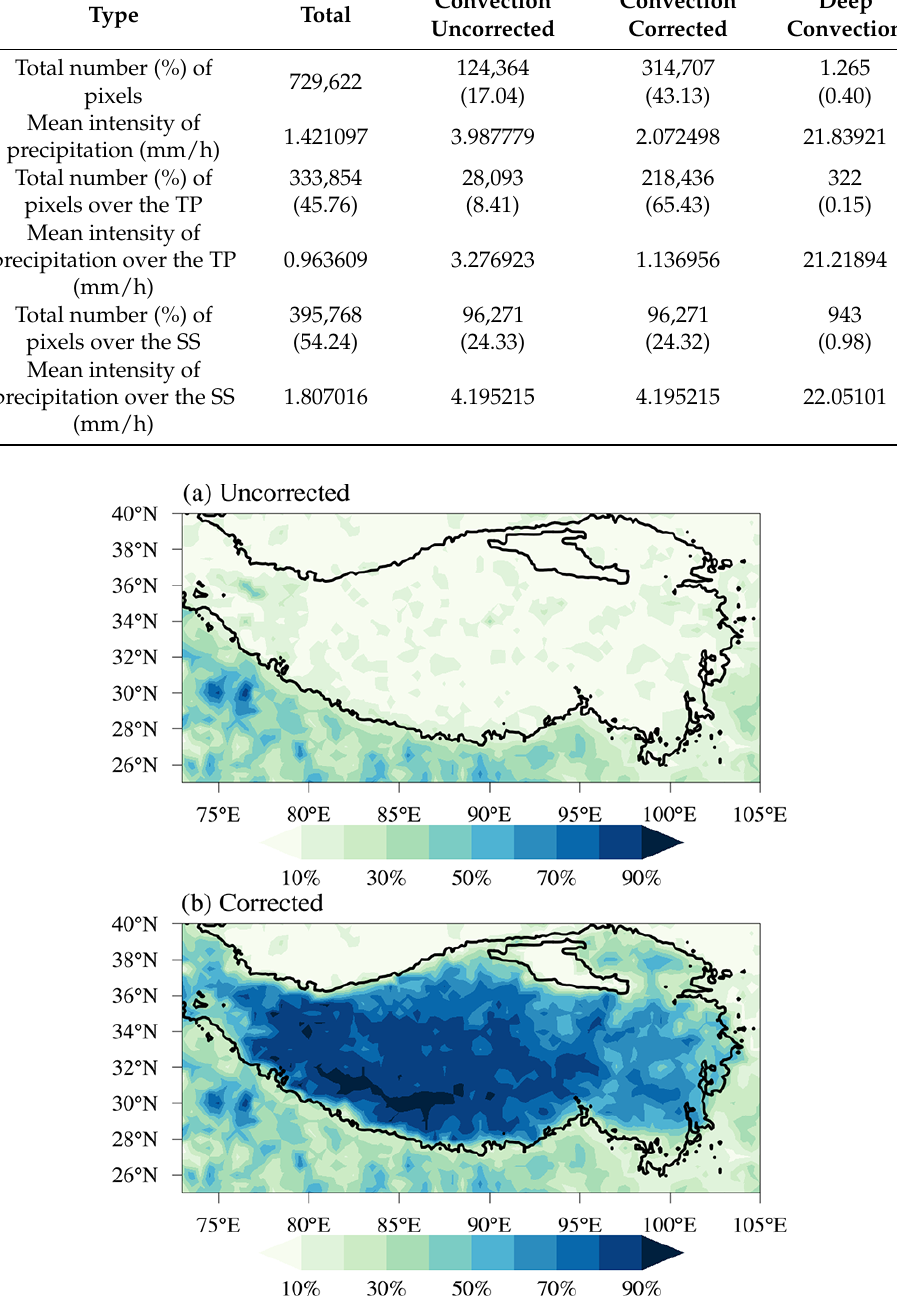
Figure 4. Percent of convective precipitation during summer (the black line is the 3000 m elevation contour) using ( a ) uncorrected data from the GPM original dataset, and ( b ) the corrected data using the re-identification method. The resolution of 0.5° × 0.5° was obtained by gridding the radar data.